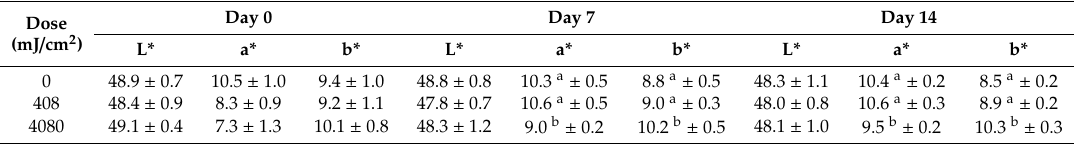
Table 5. Mean and standard error values of the color results of rolled fillets of ham depending on the UV-C dose and storage day ( n = 3).